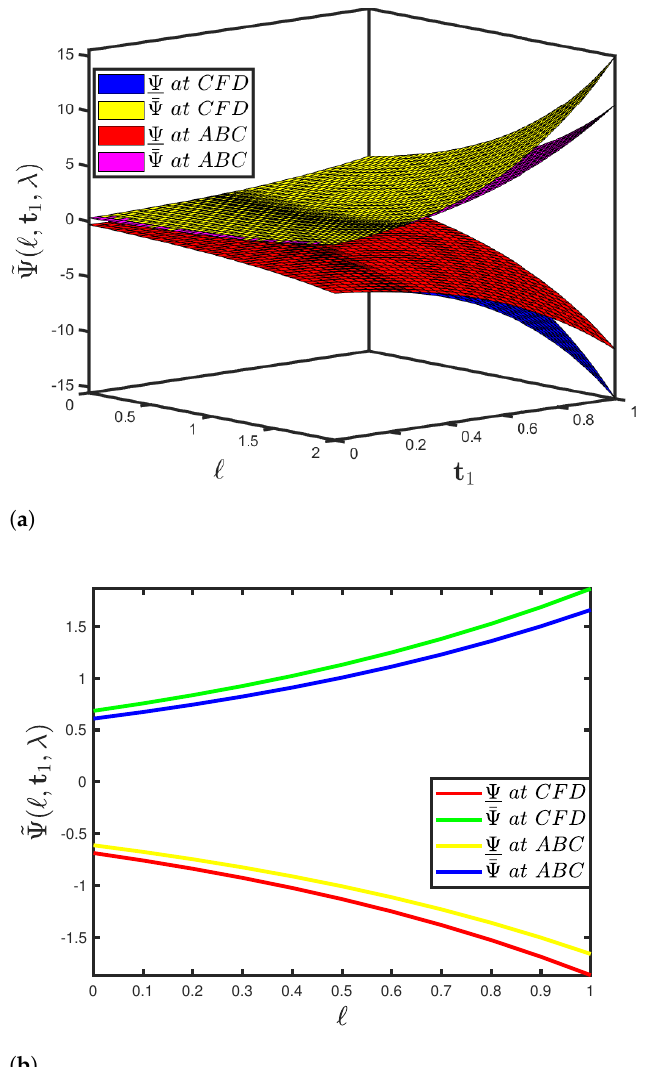
Figure 12. Comparison plots of ˜ Ψ ( (cid:96) , t 1 ; λ ) of Problem (3) when fuzzy CFD and ABC are considered to have a fractional order ϑ = 1 and uncertainty parameter λ ∈ [ 0,1 ] : ( a ) three-dimensional plot; and ( b ) two-dimensional plot of Ψ ( (cid:96) , t 1 ; λ ) and ¯ Ψ ( (cid:96) , t 1 ; λ ) when t 1 =